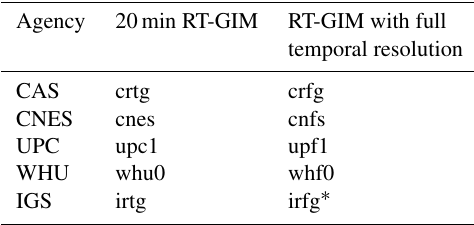
Table 3. The ID of compared IGS RT-GIMs. Agency